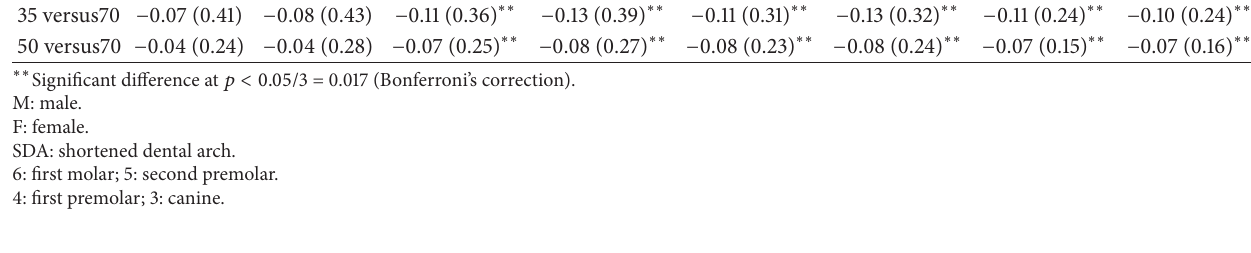
Table 5: Mean difference and standard deviation of the mean difference for paired t -test to examine the impact of subject gender on dentists’ attitudes towards